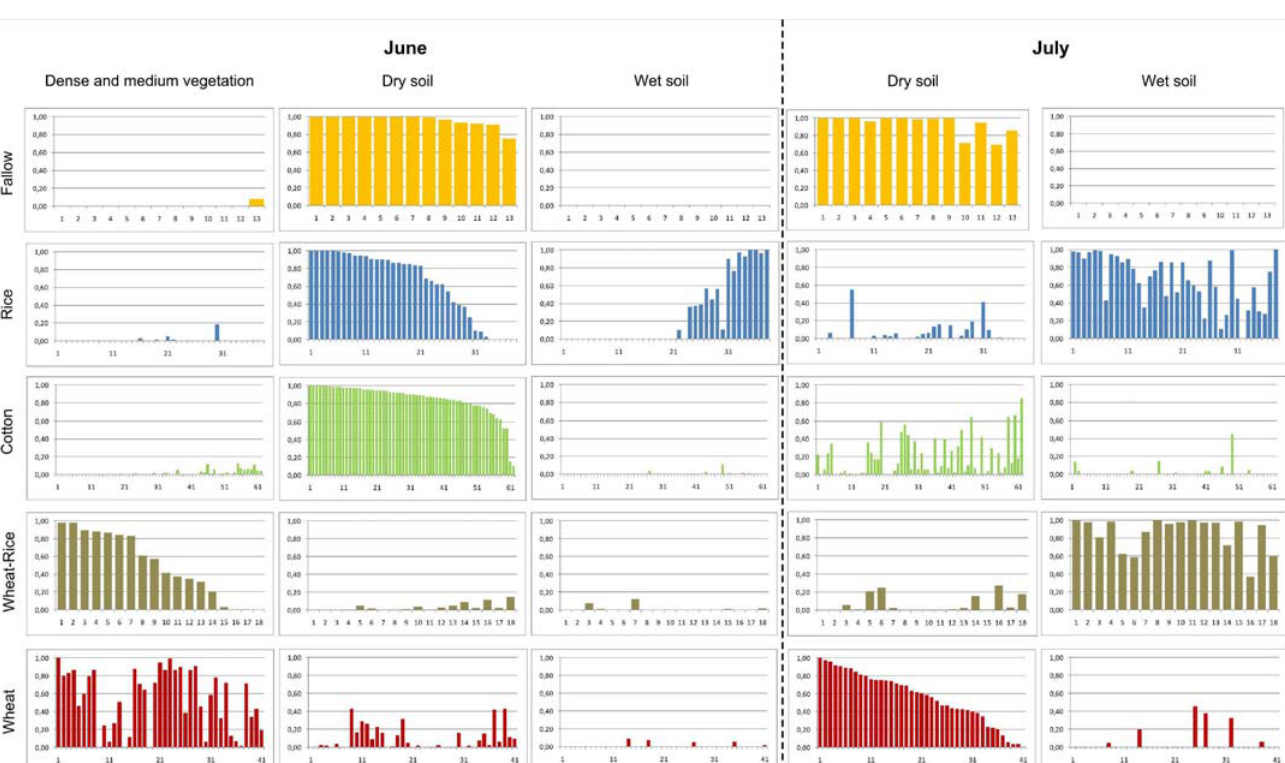
Figure 6. Within-field fractions of basic land cover classes (bar plots between 0 and 1)